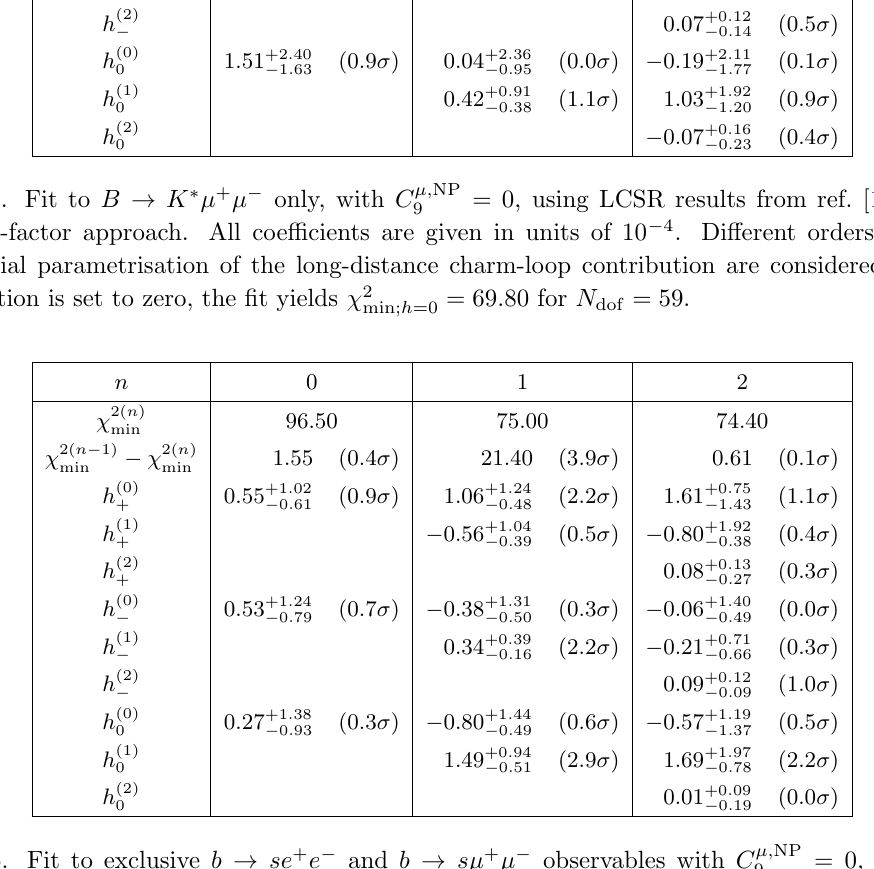
B ! K (cid:3) (cid:13) branching ratio that was not included in our earlier analyses (we have